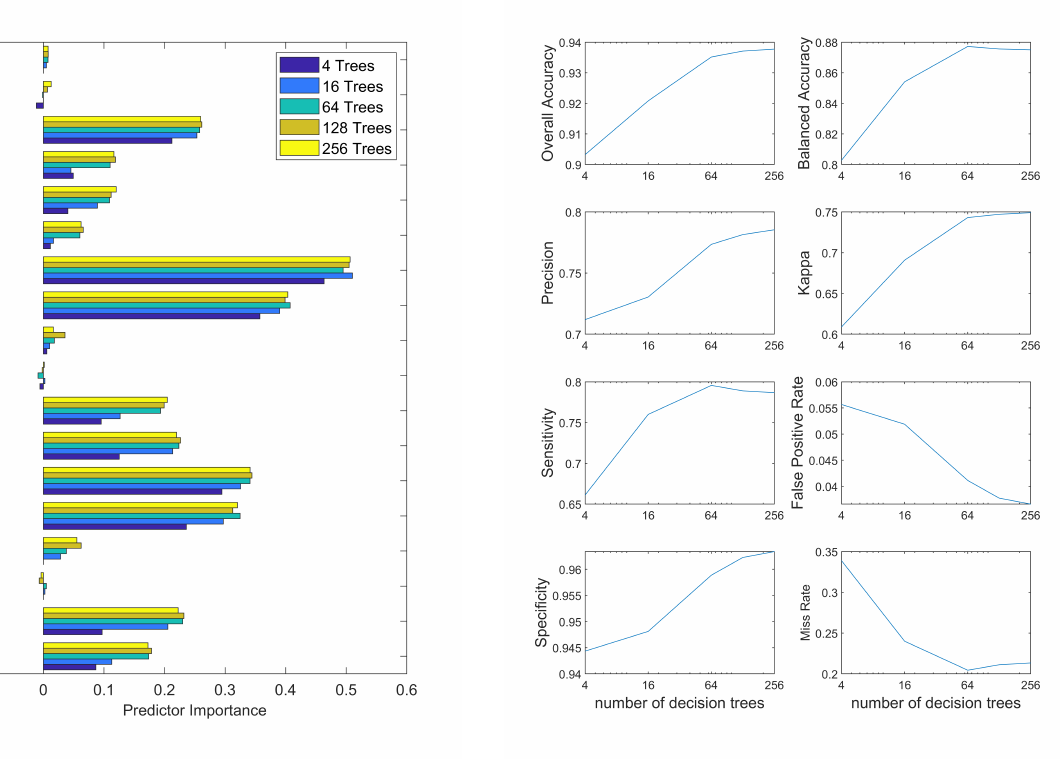
Figure 3. Predictor Importance Figure 4. Evaluation